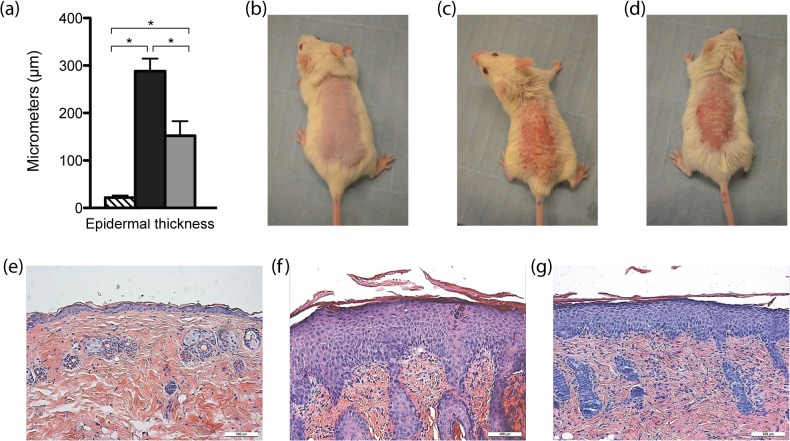
Epidermal thickness measured in skin sections, presentation of the mouse phenotype and HE sectioned skin.(a) Epidermal thickness; Means of epidermal thickness was calculated based on 15–20 random site measurements. (b-d) Presentation of phenotype of mice from control, IMQ and IMQ-RSV groups, respectively. Photograph is taken after 5 days of treatment. (e-g) HE-stained skin sections from the backs of the mice. Sections were used for evaluation of epidermal thickness. In the lower right corner of photos the white box = 100μm. Columns in a) are group means ±SEM (n = 7, n = 5, n = 5 for controls, IMQ, IMQ-RSV respectively). Clamped bar with * above indicates the pair of column means are significantly different (p<0.05). (Symbols: Striped fill = control, black fill = IMQ, grey fill = IMQ-RSV).